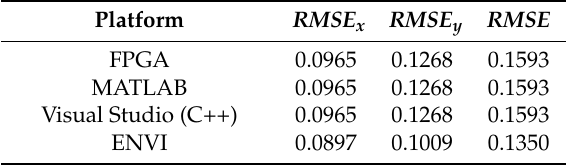
Table 5. The values of RMSE s of the georeferenced image of the second image.